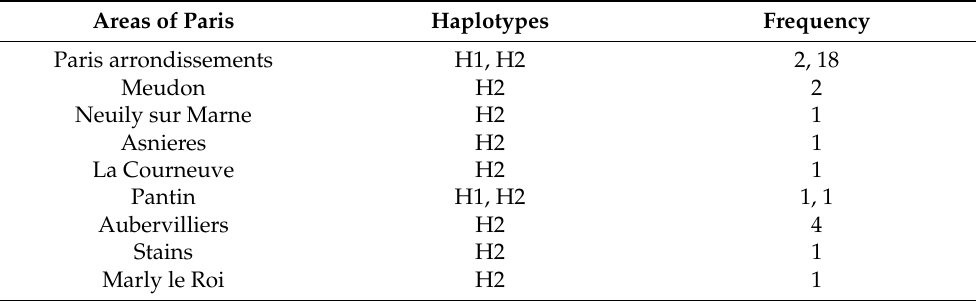
Table 2. Distribution of COI haplotypes within C. lectularius populations collected from the Paris area,